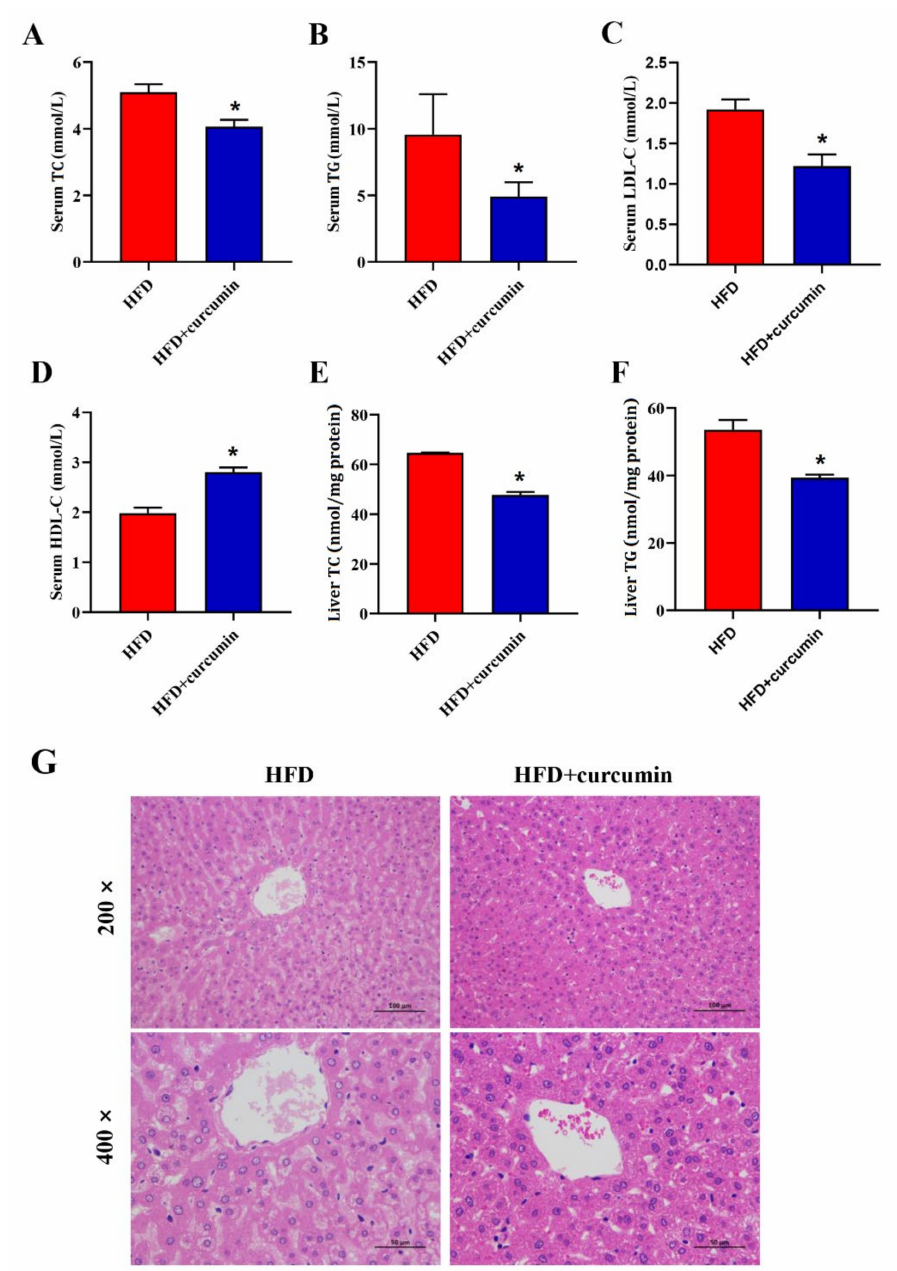
Figure 3. Effects of curcumin on serum and liver lipid metabolism in HFD-fed hamsters. ( A – D ) The serum TC, TG, LDL-C, HDL-C levels; ( E , F ) The liver TC, TG levels; ( G ) Representative H&E staining graphs of liver (200 × magnifications, 400 × magnifications). Data are expressed as mean ± SEM ( n = 8), * p < 0.05 compared to HFD group. TC, Total cholesterol; TG, Total triglycerides; LDL-C, Low-density lipoprotein cholesterol; HDL-C, High-density lipoprotein